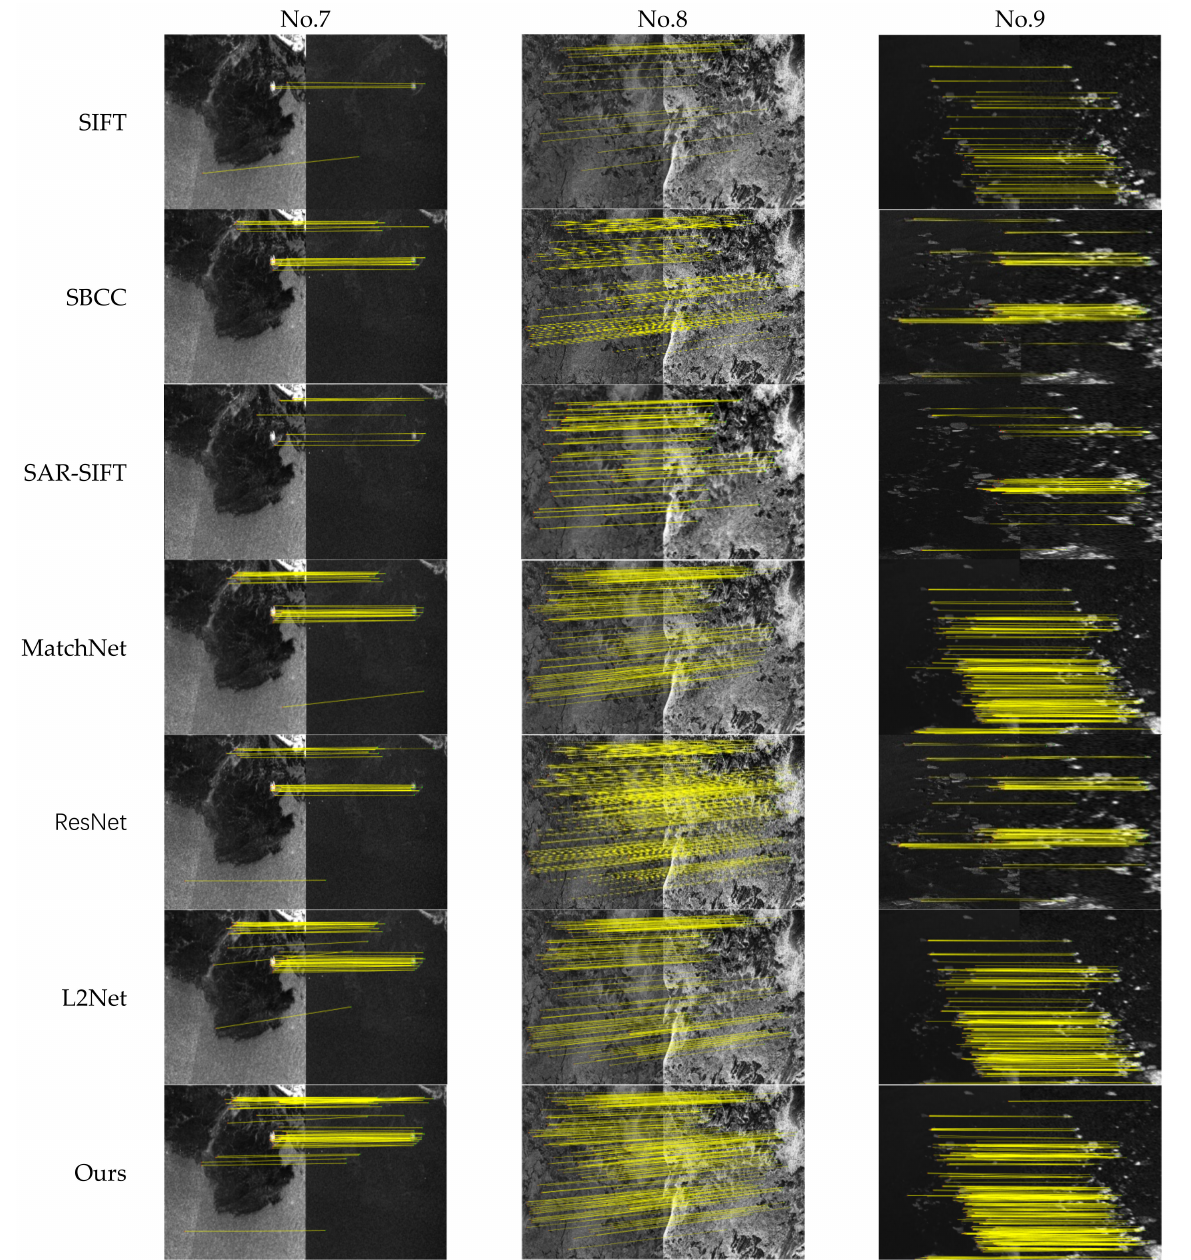
Figure 11. The correctly matching results of sea ice images with different polarization